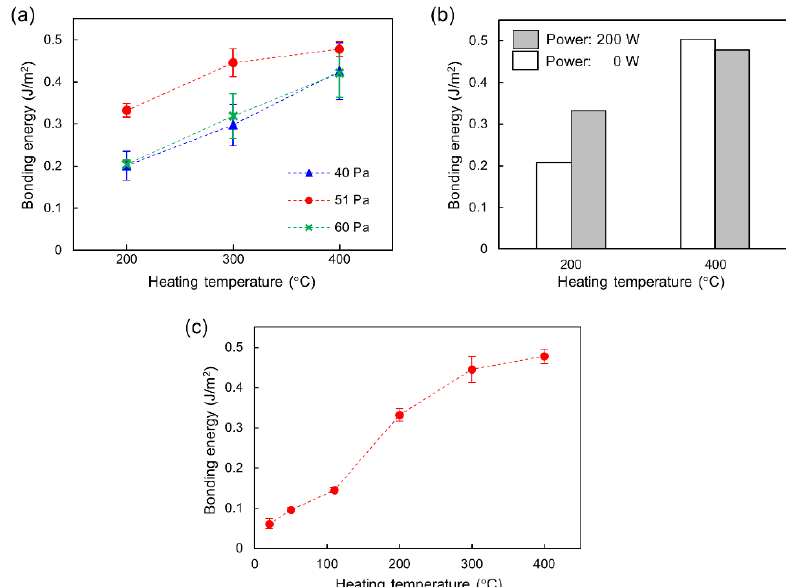
Figure 4. Bonding energy measured by a crack-opening test. ( a ) Bonding energy as a function of heating temperature at di ff erent pressures in a reaction chamber, indicating the concentration of oxygen plasma. ( b ) Comparison of bonding energy for plasma power of 0 and 200 W. ( c ) Bonding energy as function of heating temperature at a pressure in reaction chamber of 51 Pa.